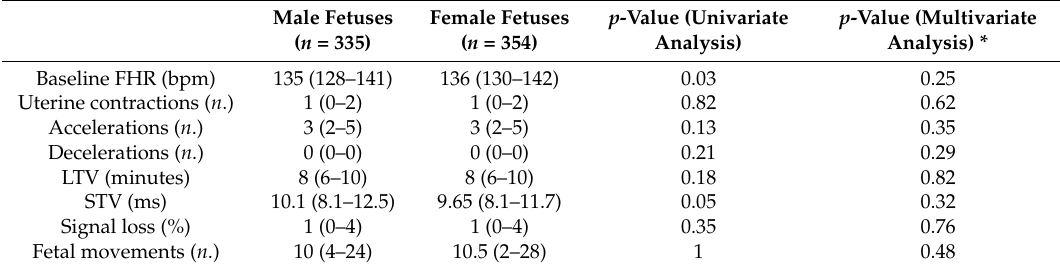
Table 2. Computerized CTG results according to fetal